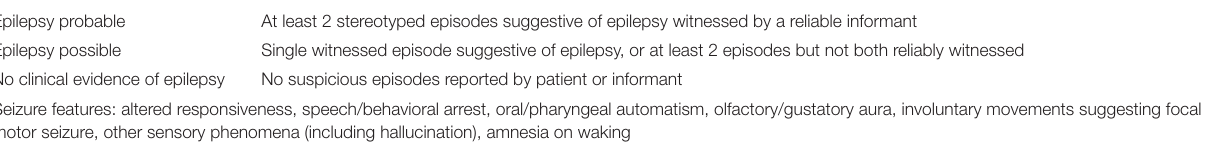
TABLE 1 | Seizure group criteria. Epilepsy